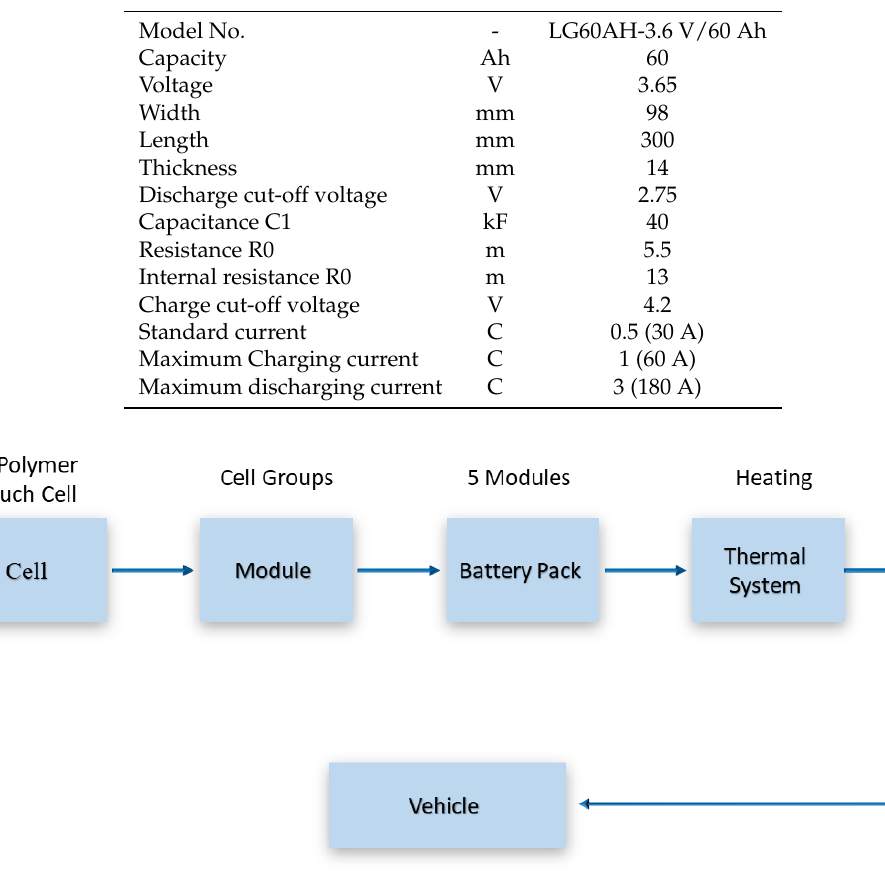
Figure 4. The process of cell to a battery pack